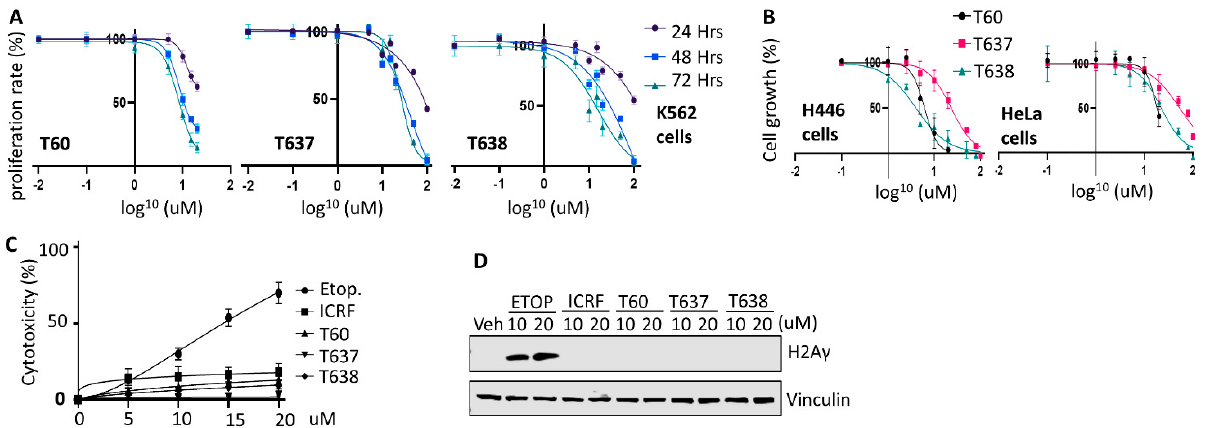
Figure 6. T638 inhibits cancer cell proliferation with low cytotoxicity. ( A ) K562 cells were treated with 0, 0.5, 1, 5, 10, 15, and 20 uM of T60 or 0, 0.5, 1, 5, 10, 15, 20, 50, and 100 uM of T637 and T638 for 24, 48, or 72 h. Cell proliferation rates were measured by MTS assays, and results were calibrated to the vehicle treatment as 100%. ( B ) NCI-H446 small cell lung cancer line and Hela cervical cancer line were treated with 0, 0.5, 1, 5, 10, 15, and 20 uM of T60 or 0, 0.5, 1, 5, 10, 15, 20, 50, and 100 uM of T637 and T638 for five days. Cell growth rates were measured by using Incucyte TM . ( C ) K562 cells were treated with 0, 5, 10, 15, and 20 uM of T60, T637, or T638 for 48 h. Cytotoxicity was evaluated by measuring the LDH levels from the culture media. ( D ) K562 cells were treated with the vehicle or 10–20 µM of etoposide, T60, T637, or T638 for 4 h. Immunoblotting measured p-H2AX γ levels in cells with vinculin as a loading control. Full Website Blot Figures are shown in the supplementary materials.